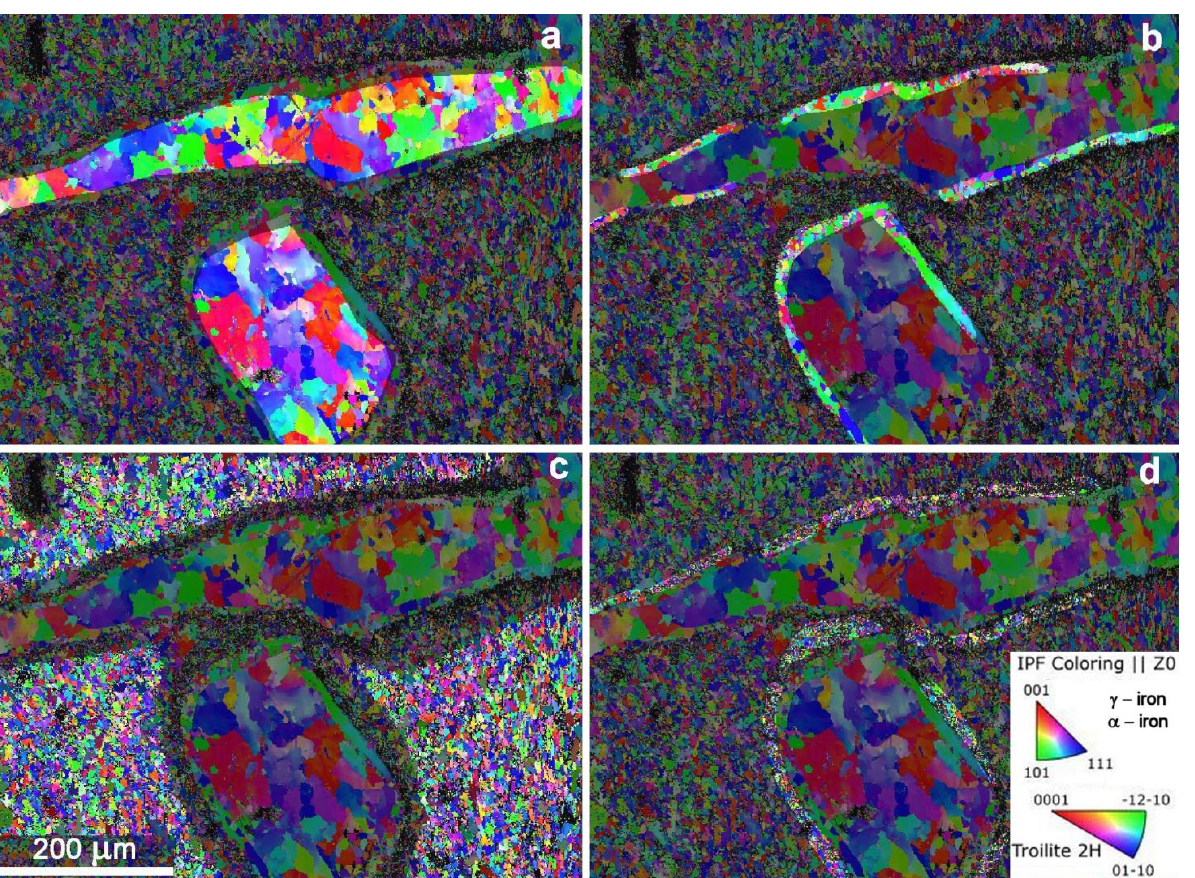
Figure 6. EBSD grain domains orientation maps of the area represented in Figure 5a; the colors represent the orientation of the selected crystallographic planes according to a projection parallel to the Z-axis for both the alpha and gamma phases; ( a ) coarse-grained alpha phase-rich area; ( b ) medium- grained, gamma-phase-rich area; ( c ) fine-grained plessitic area; ( d ) extra-fine-grained plessitic area. Band contrast (BC) images (Figure 7), which resemble SEM-BSE images, were also used to check the quality of the EBSD pattern and to show the areal distribution of bcc, fcc and other phases. Regarding the phase distribution, Figure 7 shows the combined band contrast and the BSE images of two areas of the polished Oglat Sidi Ali sample at different scales. The surfaces of both areas consisted of an aggregate of Fe-Ni phases (either bcc- alpha phase or fcc-gamma phase) with minor small troilite and nickel-phosphide grains. The large homogeneous areas of the alpha phase lamellae appeared to be surrounded by rims of the gamma phase, while the remaining areas consisted of a fine-grained inter- mixed aggregate of bcc-alpha and fcc-gamma phases, which are commonly defined as a plessitic texture [12], with the alpha phase prevailing over the gamma one.